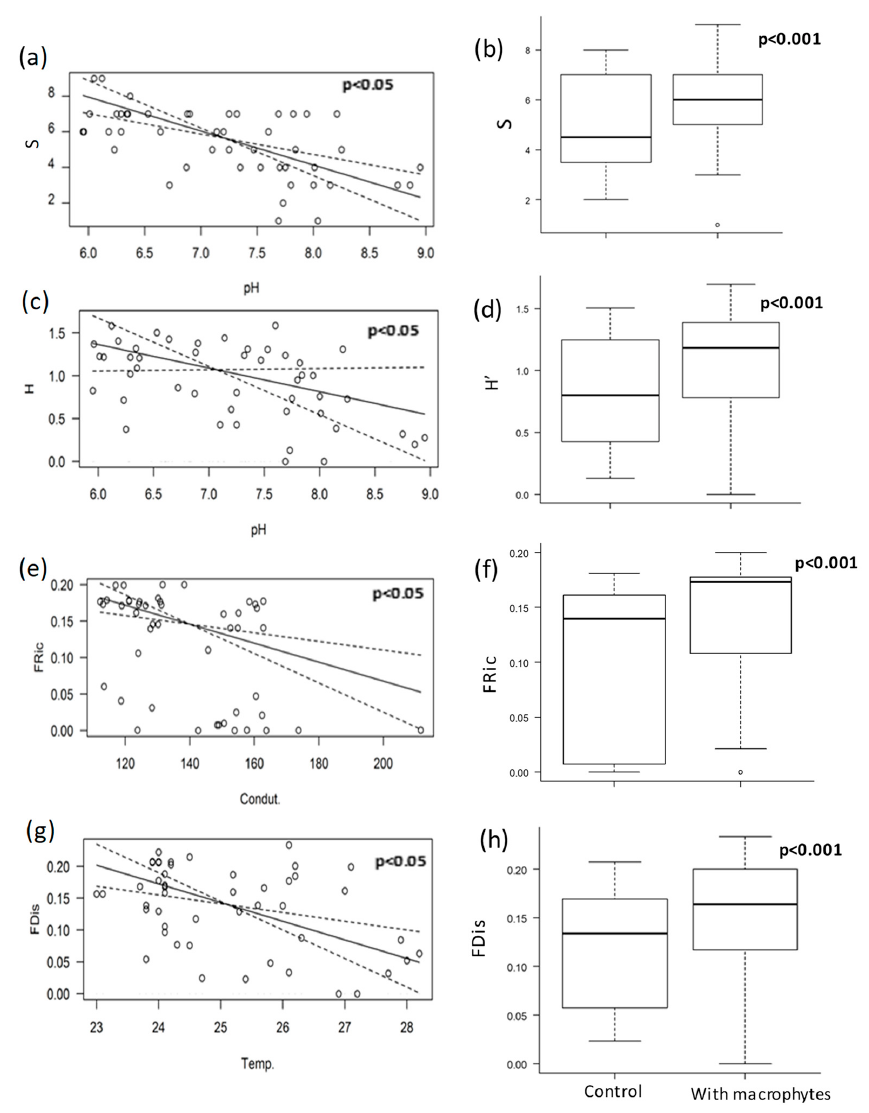
Figure 2. Relationships between: ( a ) species richness ( S ) and pH, adjusted R 2 = 0.42; F 3,22 = 214.59; ( b ) species richness ( S ) by treatment ( S = 5.0131 + s(1.4836, Macro) + s(1.0, pH) + a i; a i N (0, 1.372)); ( c ) Shannon species diversity ( H’ ) and pH, adjusted R 2 = 0.3; F 3,22 = 106.07; ( d ) Shannon species diversity ( H’ ) by treatment (H = 0.852 + s(0.308, Macro) + s(1.0, pH) + a i ; a i N (0, 0.357)); ( e ) functional richness ( FRic ) and conductivity, adjusted R 2 = 0.29; F 3,22 = 47.1; ( f ) functional richness ( FRic ) by treatment ( FRic = 0.097 + s(0.0508, Macro) + s(1.0, Conduct.) + a i ; a i N (0, 0.0403)); ( g ) functional dispersion ( FDis ) and temperature, adjusted R 2 = 0.26; F 3,22 = 90.81; ( h ) functional dispersion ( FDis ) by treatment ( FDis = 0.122 + s(0.0519, Macro) + s(1.0, Temp.) + a i ; a i N (0, 0.0572)). Obs.: only statistically significant results are